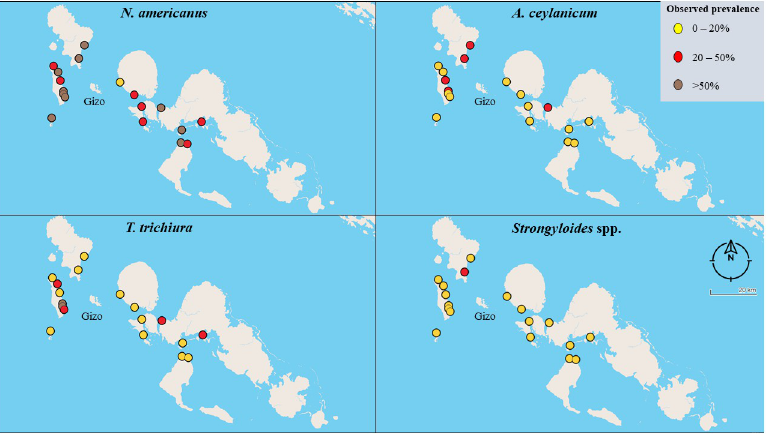
Fig 2. Map showing the observed prevalence of infections with N . americanus , A . ceylanicum , T . trichiura , and Strongyloides spp. across 18 villages in Western Province.